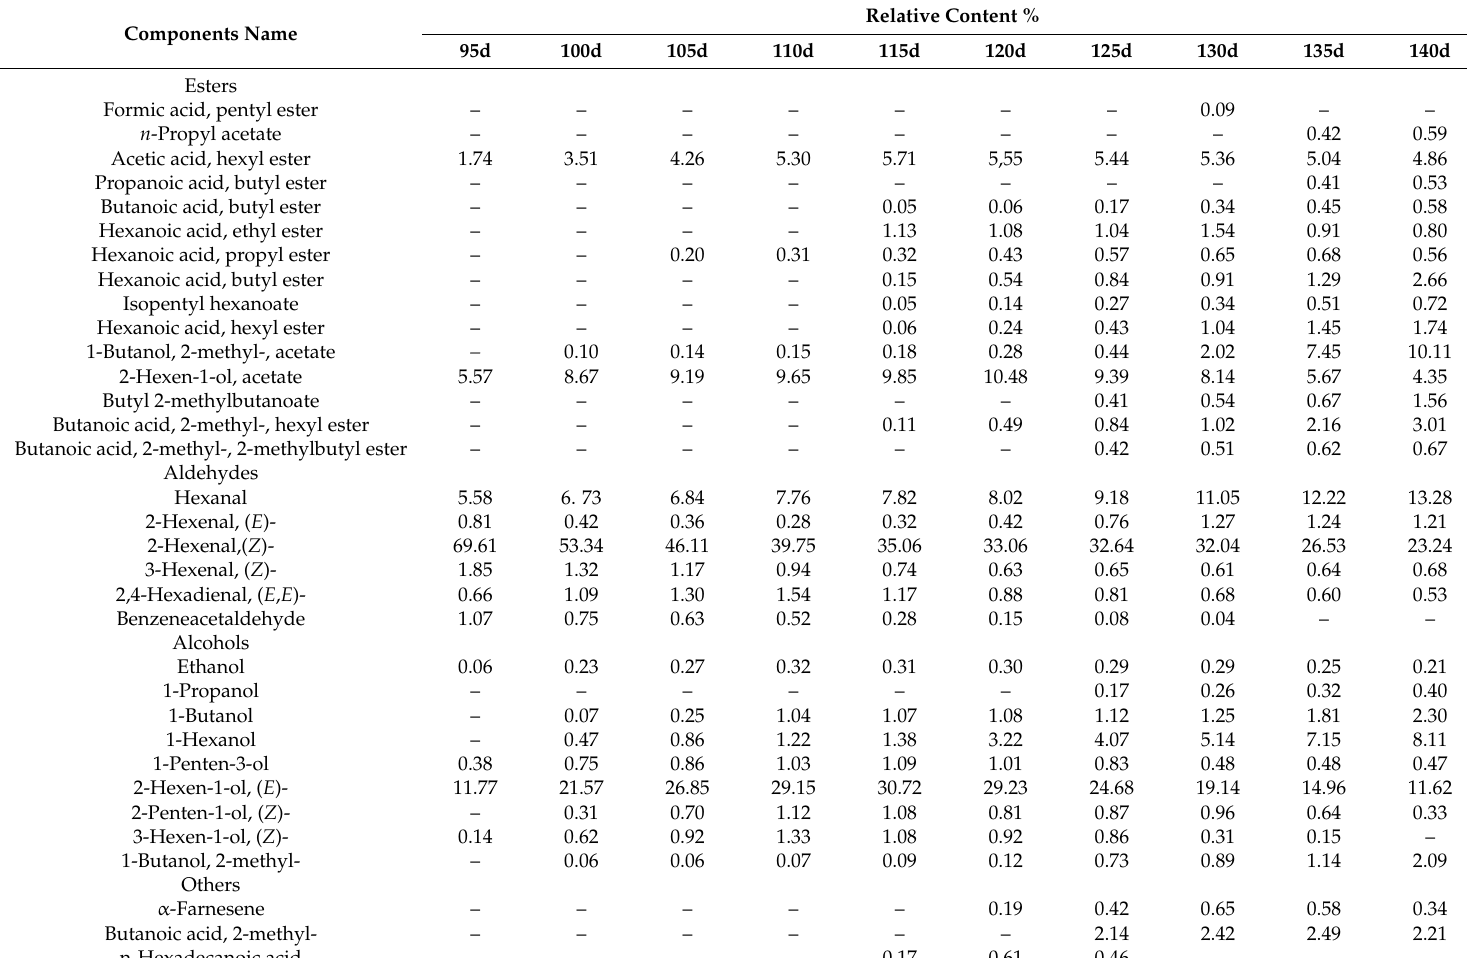
Table 2. Main aroma components of “Starkrimson” apple during fruit